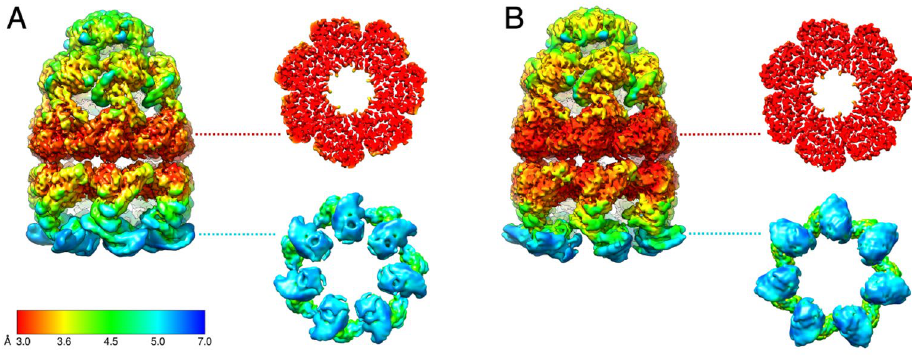
Figure 3. Cryo-EM structures (C7) of the bullet-shaped GroEL–GroES complex coloured according to local resolution. “Tight” ( A ) and “wide” ( B ) conformations are shown with additional slices through equatorial and apical domains.